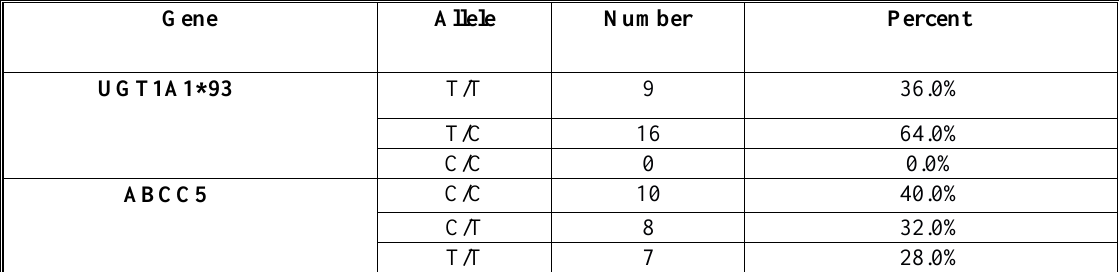
Table 4. prevalence of studied mutation in patients